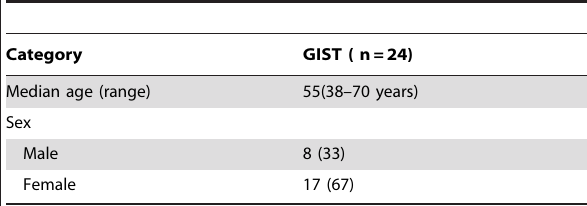
Table 1. Patient, Tumors and Treatment Characteristics (n=24).